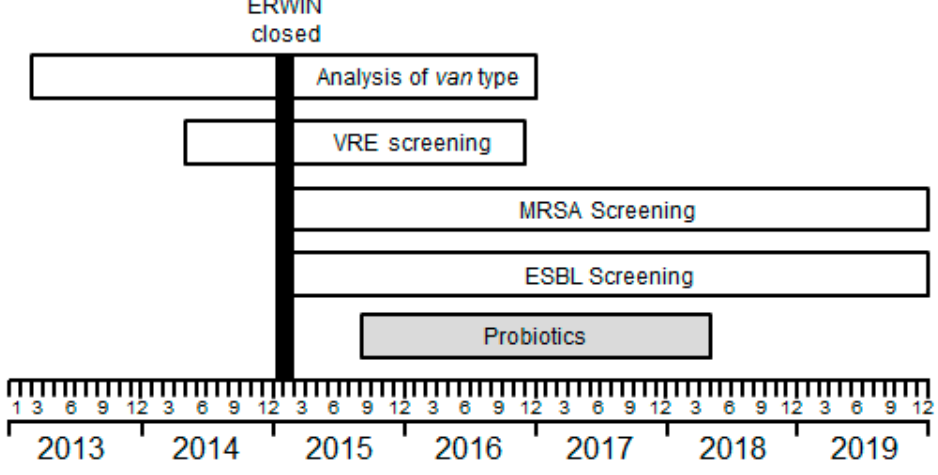
Figure 1. Overview of infection control measures performed on early rehabilitation ward of Ingolstadt hospital (ERWIN) between January 2013 and December 2019. Rectal swabs were taken from each patient treated on ERWIN at admission and once per week between May 2014 and November 2016 to identify colonization with vancomycin-resistant Enterococcus faecium (VRE). From 2013–2016, the type of the gene ( van A, van B, etc.) that mediated vancomycin resistance of VRE was systematically examined. ERWIN was temporarily closed during January and February 2015 for deep cleaning and disinfection of the ward following an outbreak of carbapenem-resistant Klebsiella pneumonia . Upon reopening the ward, each patient was screened at admission and once per week for colonization with extended spectrum beta-lactamase (ESBL)-producing Gram-negative bacteria and methicillin-resistant Staphylococcus aureus (MRSA). From 2010 to 2012, no additional infection control measures were performed on ERWIN.